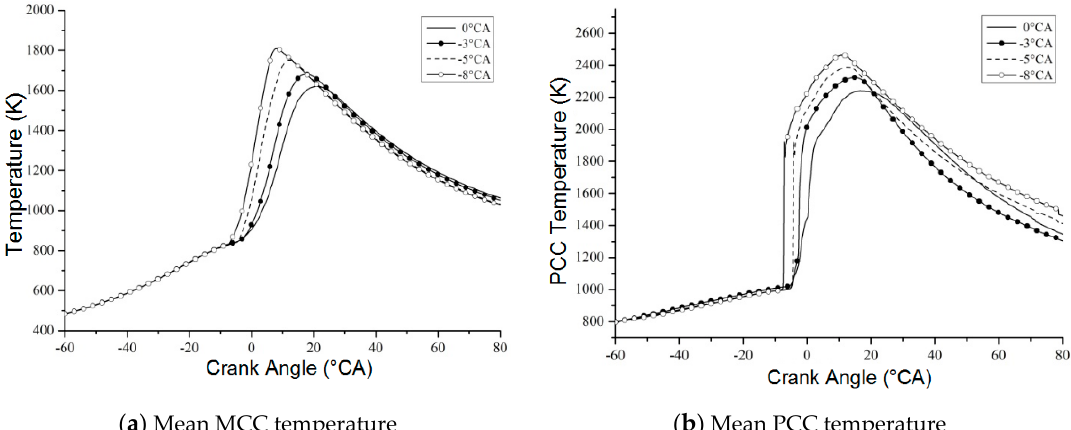
Figure 16. Mean temperature under different pilot SOI timing.